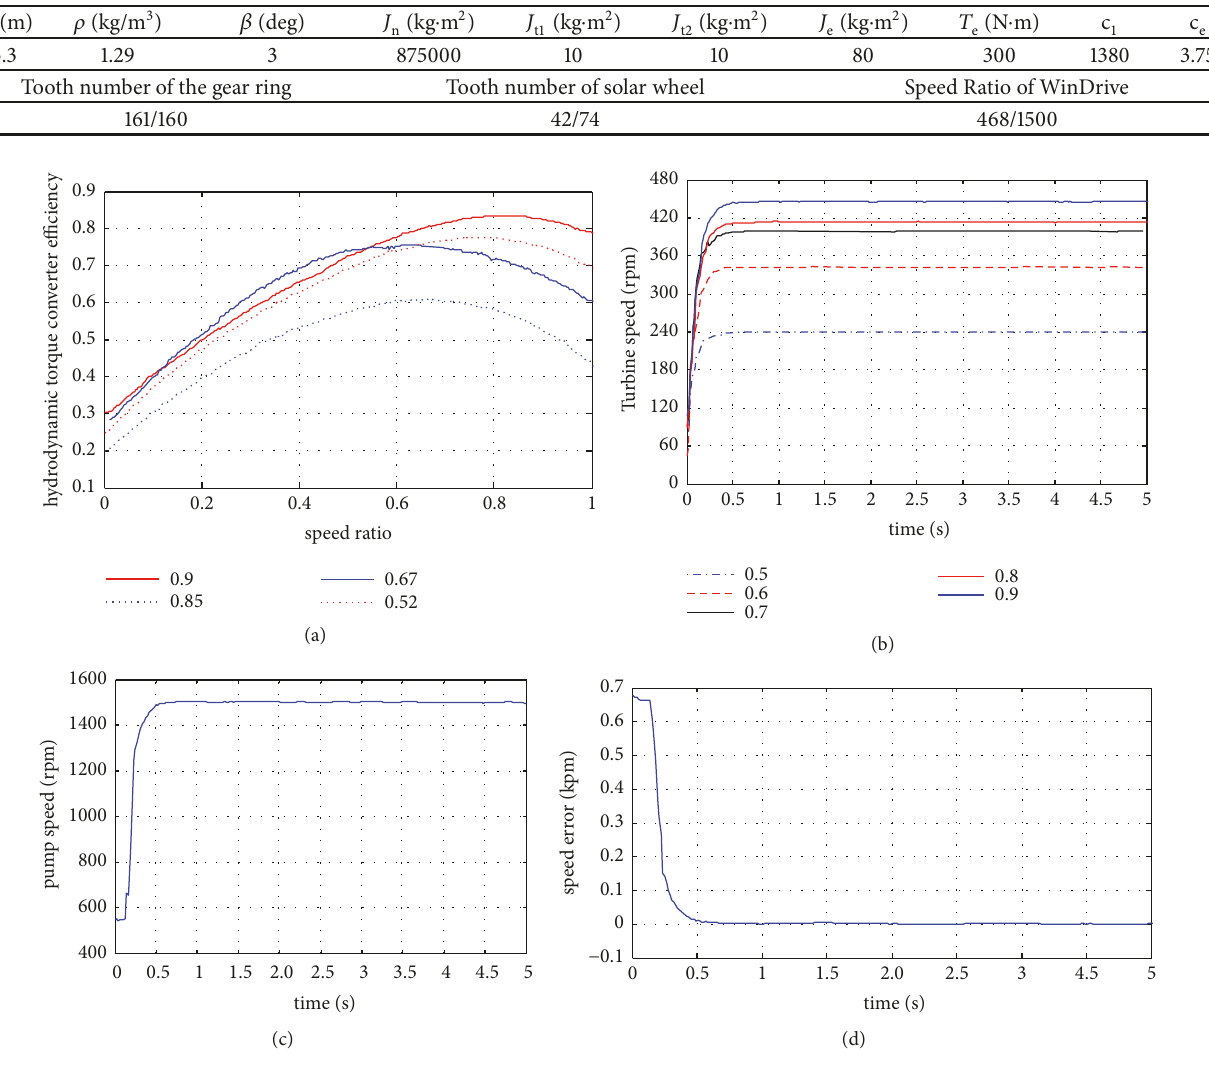
Table 1: Parameters of the wind turbine and its drive chain used for simulation.